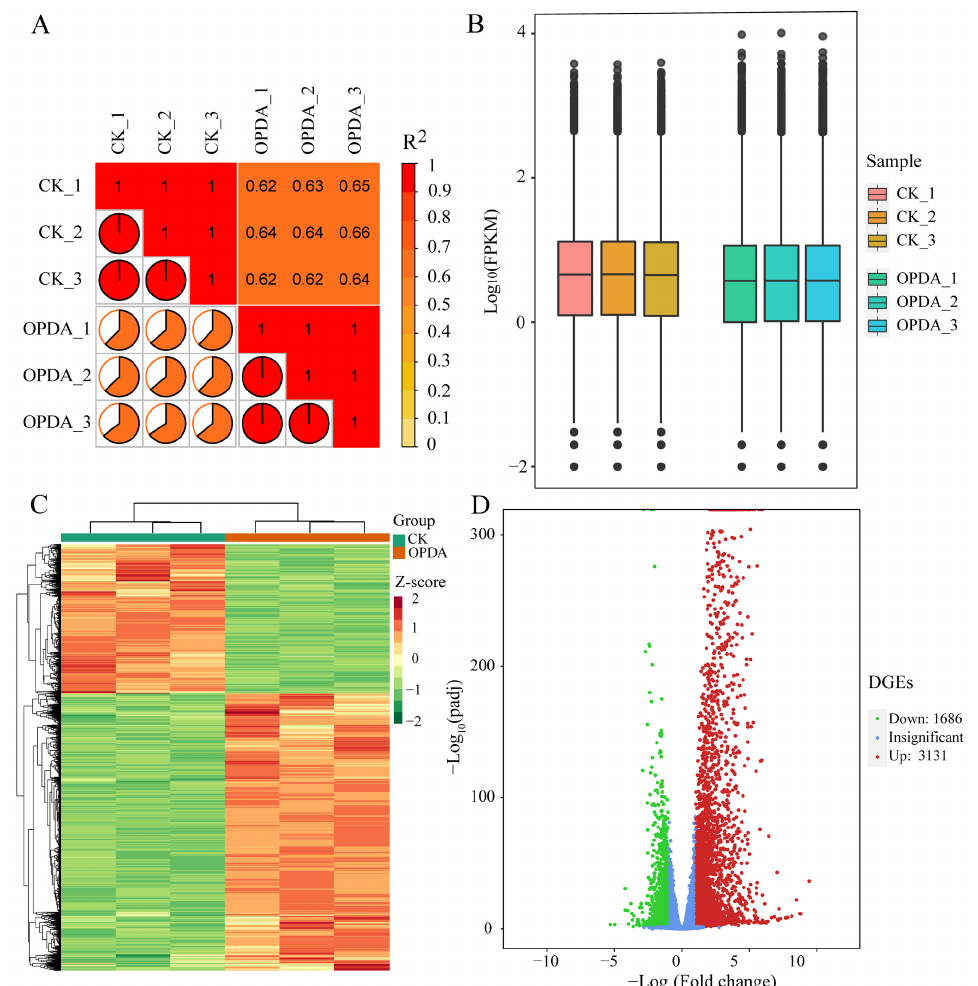
Figure 3. Transcriptome sequencing analysis of Pohlia nutans under OPDA treatment. ( A ) RNA- sequencing data from different samples were compared using Pearson correlation coefficient (r 2 ) to evaluate parallel levels in each group. The closer r 2 is to 1, the stronger the correlation between the two duplicate samples. The number in charts and the orange or red ratio in pie charts both represent the value of the correlation coefficient (r 2 ) between the two samples. ( B ) The box diagram compared the gene expression levels in different samples. There were five statistics for each region (top-down: maximum, upper quartile, median, lower quartile, and minimum), and the width of each box indi- cates the number of genes. ( C ) Hierarchical clustering analysis (HCA) for differentially expressed genes (DEGs). In clustering heatmap, horizontal ordinate shows the sample name and vertical ordi- nate indicates the DEGs. The dendritic plot to the left of the heatmap represents DEGs clustering after HCA analysis. ( D ) The volcano plot showing the DEGs between different groups. X-axis indi- cates fold change (threshold, |log 2 (Fold Change)| > 1), while Y-axis means the statistically signifi- cant level (threshold, log 10 (padj) > 1.3). We further accessed the global profiles of differentially expressed genes (DEGs), which were screened based on the threshold of adjusted p -value < 0.05 and |log 2 (foldchange)| >1.